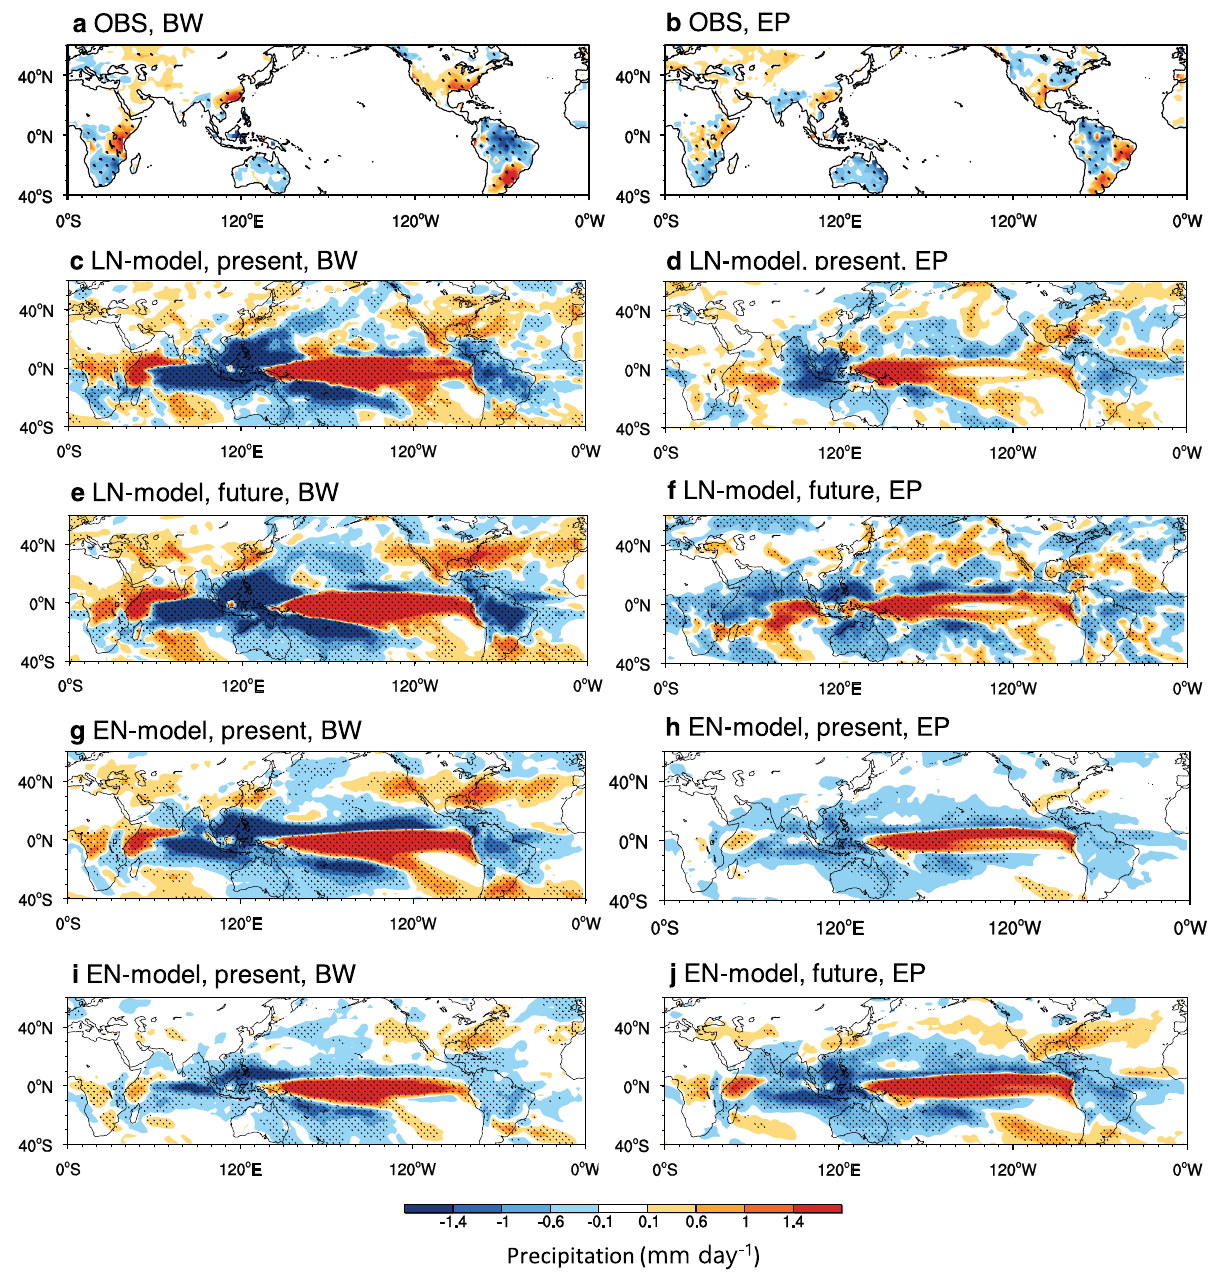
Fig. 4 Future precipitation changes associated with El Niño diversity. a , b Composites of boreal winter (October to February) precipitation anomalies (shading, mm day − 1 ) induced by Basin-Wide (BW) and Eastern Paci fi c (EP) types of El Niño derived from observations. c , d Same as a , b but for the present run of the model with La Niña-like mean SST change (LN-Model). The present represents the historical run (1943 – 1992) from the 18 climate models with two ensemble members. e , f Same as c , d but for the future period from both Representative Concentration Pathway (RCP) 4.5 and RCP8.5 (2038-2087). g , h Same as c , d but for the present run of the model with El Niño-like mean SST change (EN-Model). i , j Same as g , h but for the future period. All data are applied to a high-pass spectral fi lter (13 years) to eliminate global warming and long-term climate variability. The stippling denotes the regions where the signal (group mean) is larger than the noise (one standard deviation from the group mean of each